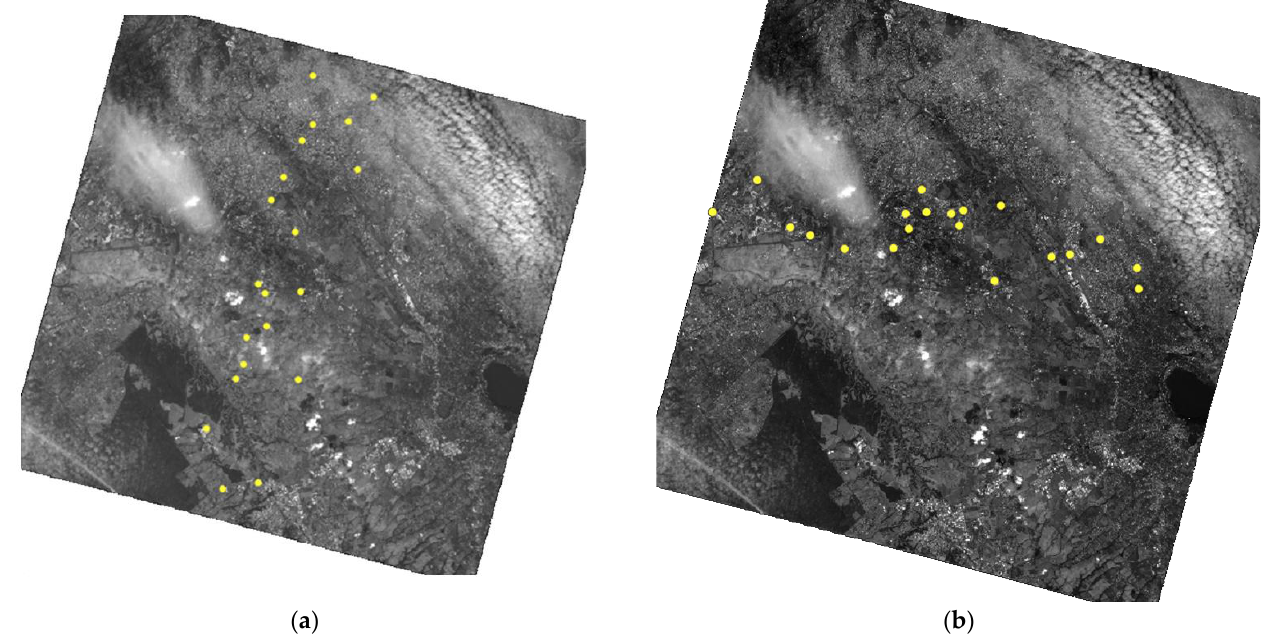
Figure A1. Ground point distribution in N-S ( a ) and E-W ( b ) direction, test field of